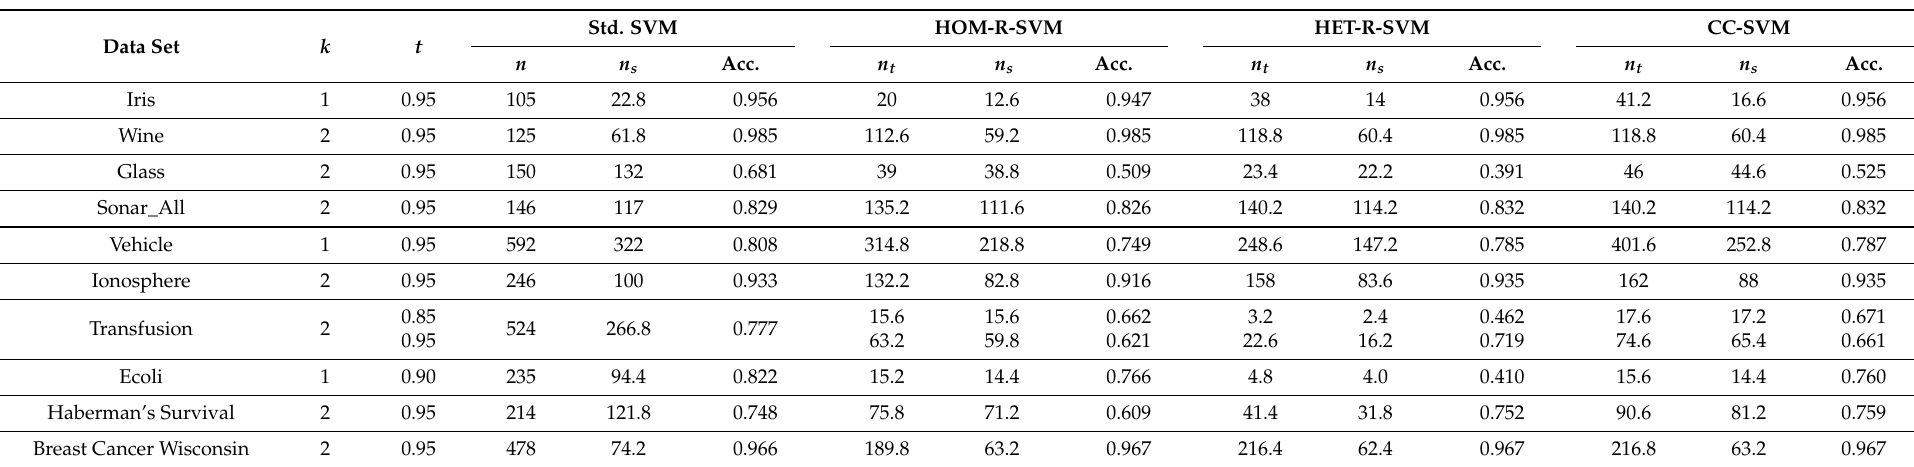
Table 3. The summary of SVM algorithms’ simulations.